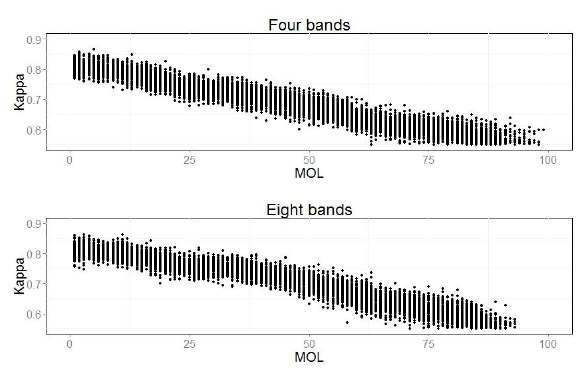
Figure 4. Kappa × MOL for each